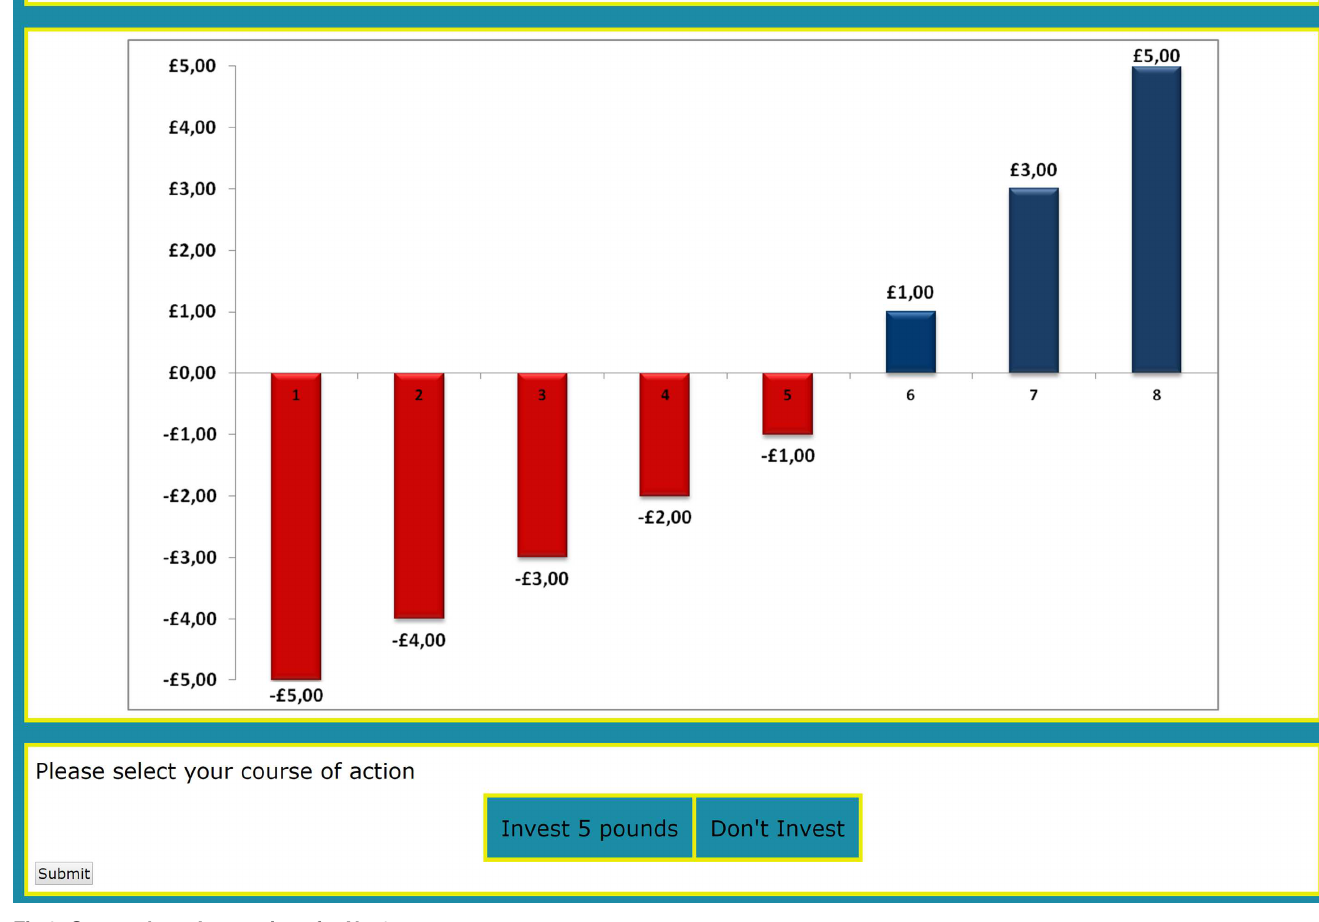
Fig 2. Screenshot—Instructions for N =